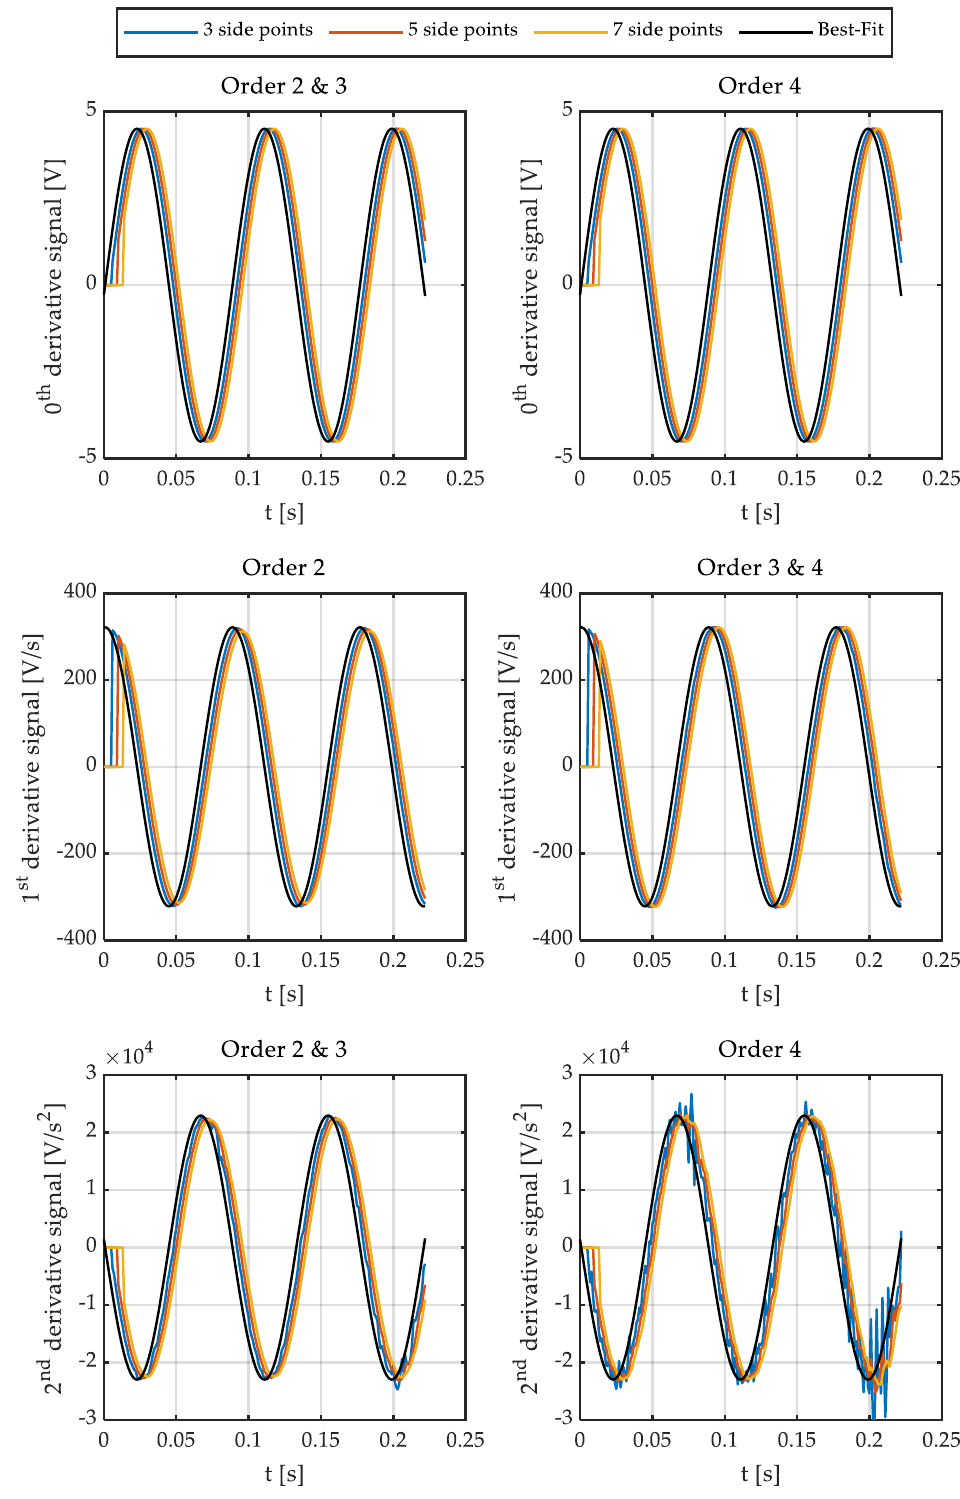
Figure 1. Signals fitted by a sine (black) and signals fitted by polynomials using the Savitzky-Golay method. ( top ) zeroth derivative. ( center ) first derivative. ( bottom ) second derivative.